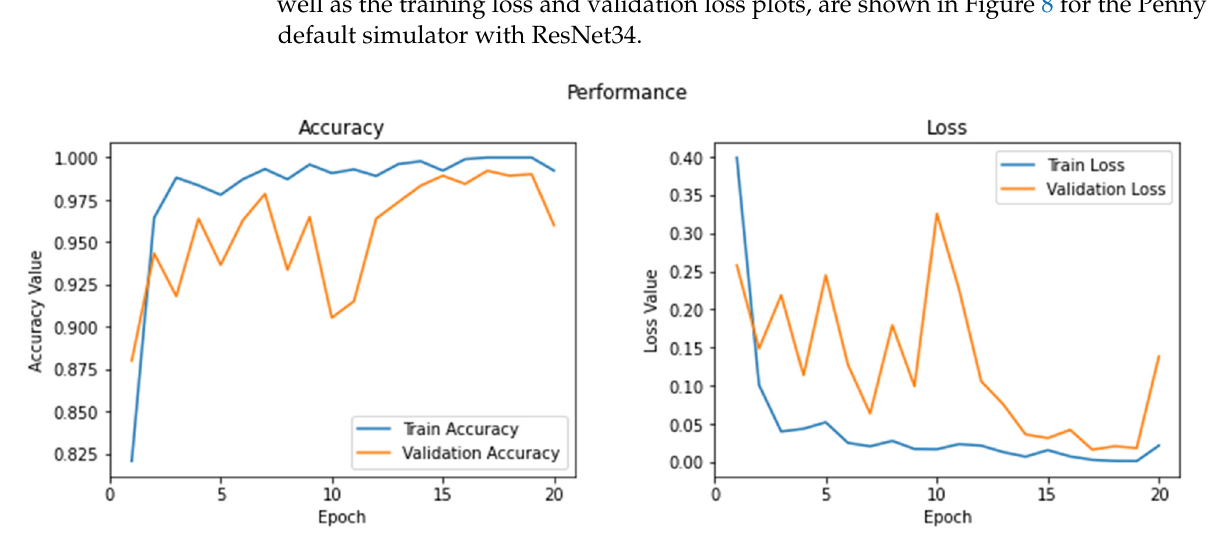
Figure 8. Accuracy plot and loss plot for pennyLane default simulator with ResNet34.